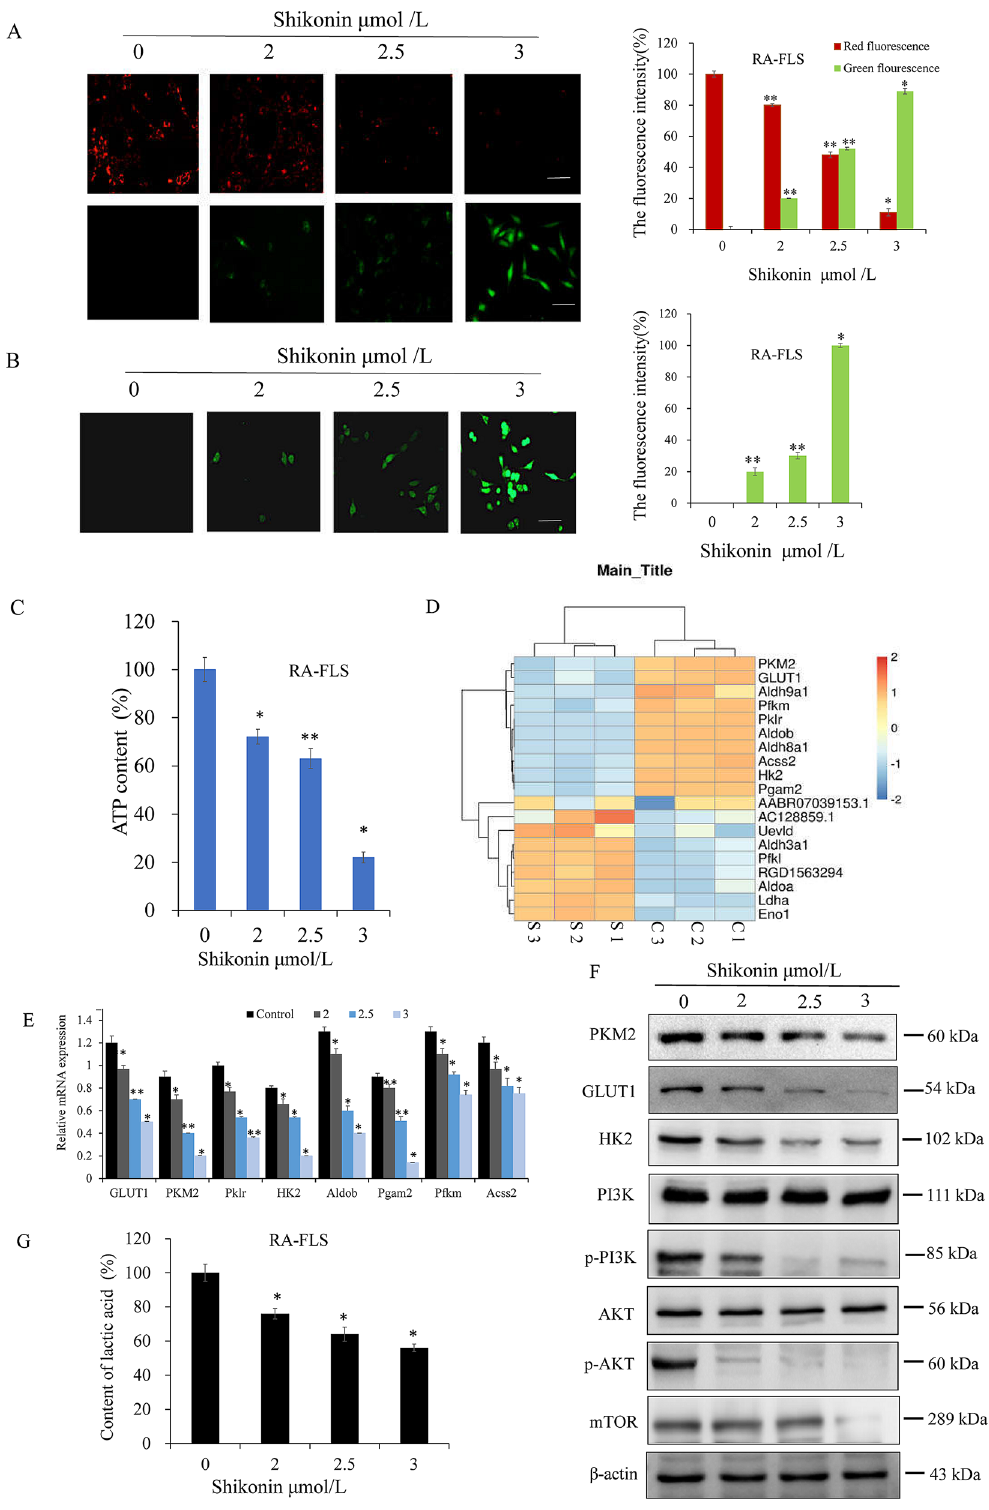
Figure 1. Effects of shikonin induction on energy metabolism in RA-FLSs. ( A ) The mitochondrial membrane potential of RA-FLSs after adding increasing concentrations of shikonin for 24 h (red indicates normal mitochondrial membrane potential). ( B ) Intracellular ROS changes in RA-FLSs at different concentrations of shikonin after 6 h. ( C ) Intracellular ATP changes detected using an ATP kit in RA-FLSs treated with different concentrations of shikonin for 6 h. ( D ) Genes related to glycolysis with a larger difference compared to the control group that were selected from the gene chip results. ( E ) RT-qPCR verified the above differentially expressed genes. ( F ) Western blot showing the protein levels of glycolysis-related proteins and related signaling pathways in RA-FLSs treated with different concentrations of shikonin for 24 h. ( G ) Intracellular lactic acid changes detected by using a lactic acid kit. * p < 0.05, ** p < 0.01 vs Control group. Scale bar represents 200 μm. Data are representative of at least three independent experiments. S Shikonin, C